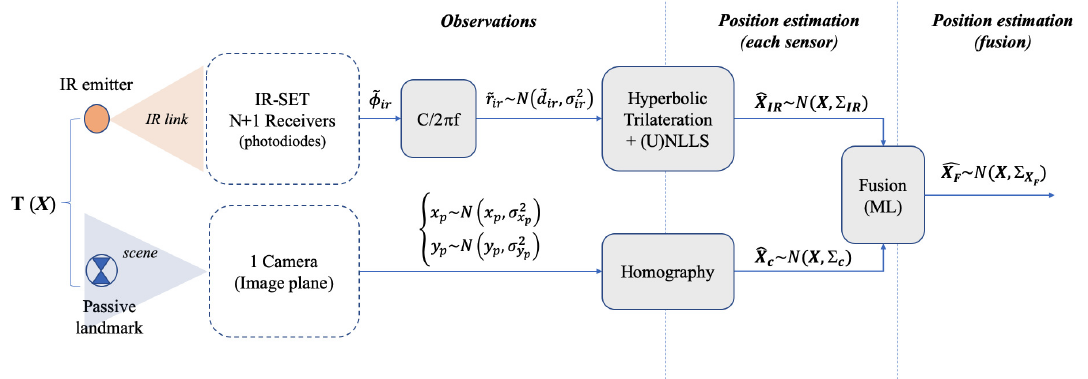
Figure 1. Block diagram description of the